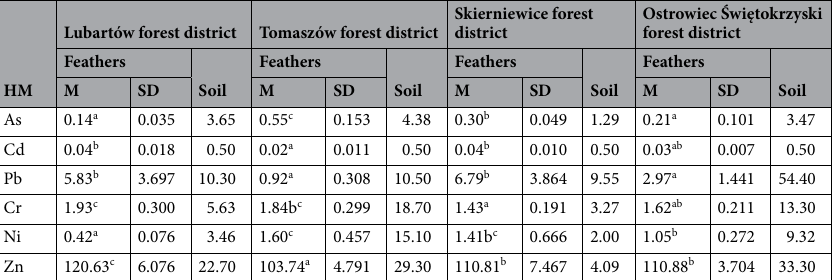
Table 2. Mean concentration level of heavy metals (mg/kg) in pheasant feathers lived in individual forest districts and of soils 52 . M mean, SD standard deviation. a,b,c Average differences statistically significant at the level of P < 0.05 in metal content between areas P < 0.05.